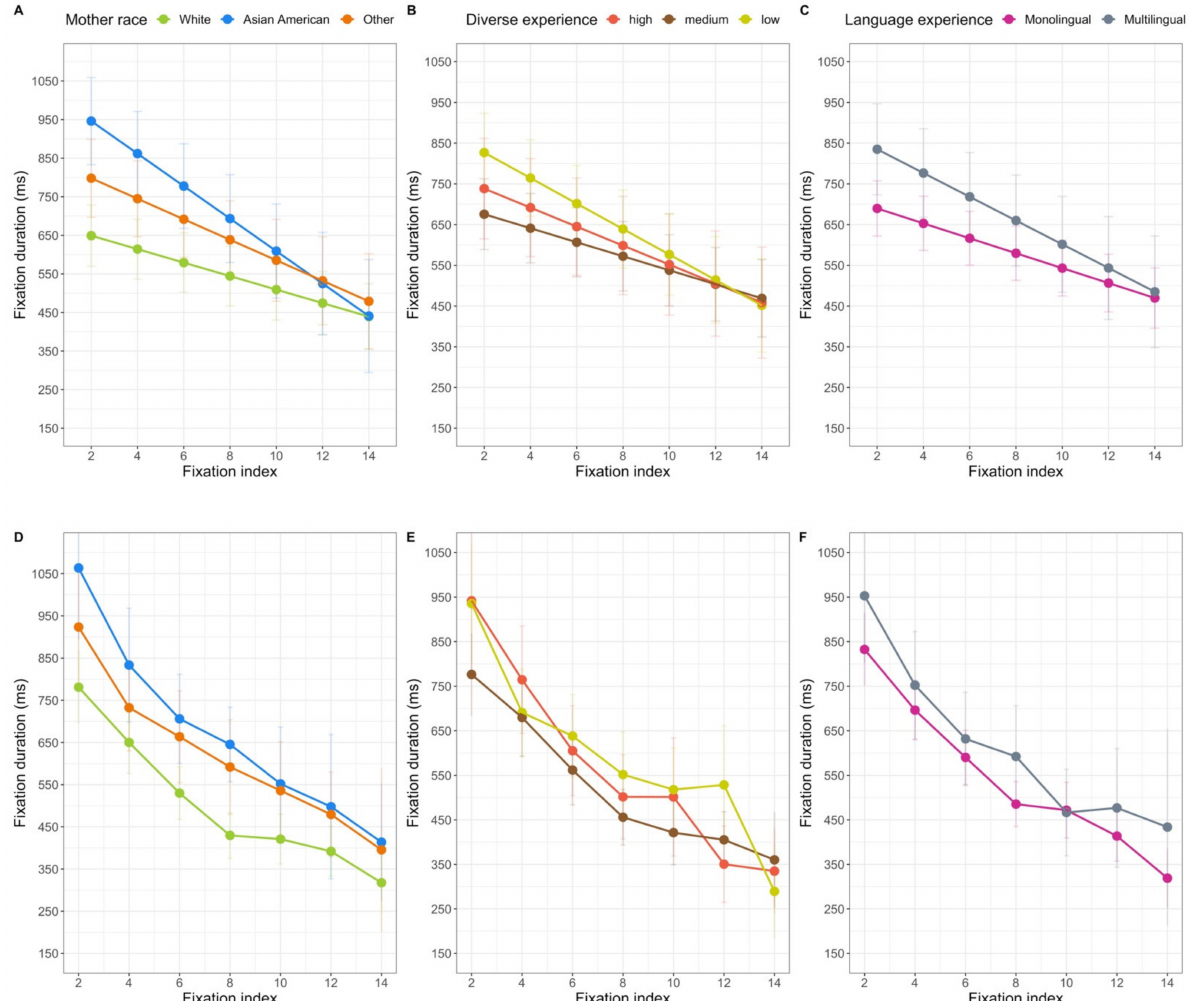
Figure 9. Top: The estimated marginal means for the duration of fixations at each fixation index as a function of experience: ( A ) mother’s race ( B ) diversity of experience, and ( C ) language experience. Bottom: the observed means for the duration of fixations at each fixation index as a function of experience: ( D ) mother’s race ( E ) diversity of experience, and ( F ) language experience. Error bars represent non-adjusted 95% confidence intervals. Although fixations are only plotted to fixation index 14, all fixations were entered in the